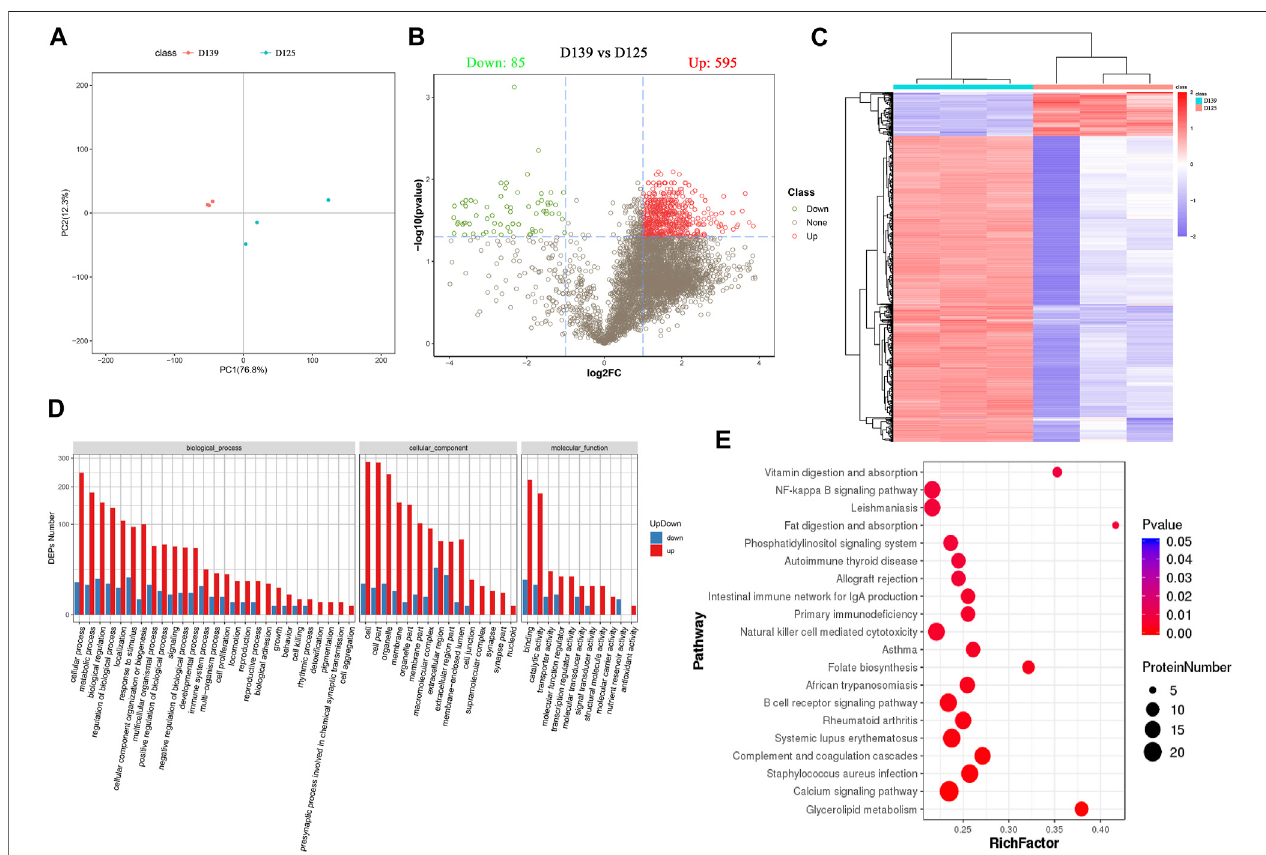
FIGURE3| Identi fi cationandfunctionalenrichmentanalysesofDEPsinchickenovaryduringsexualmaturity. (A) Principalcomponentanalysis(PCA)distributionof 6 samples. (B) 680 DEPs (595 upregulated and 85 downregulated) were presented in a volcano plot. (C) The hierarchical cluster analysis of DEPs. (D) The signi fi cance termsofbiologicalprocess,cellularcomponent,andmolecularfunction;redandblueshowup-anddown-regulationinthesexuallymature(D139)andimmaturechicken ovaries (D125), respectively. (E) Top 20 signi fi cantly changed pathways associated with DEPs.